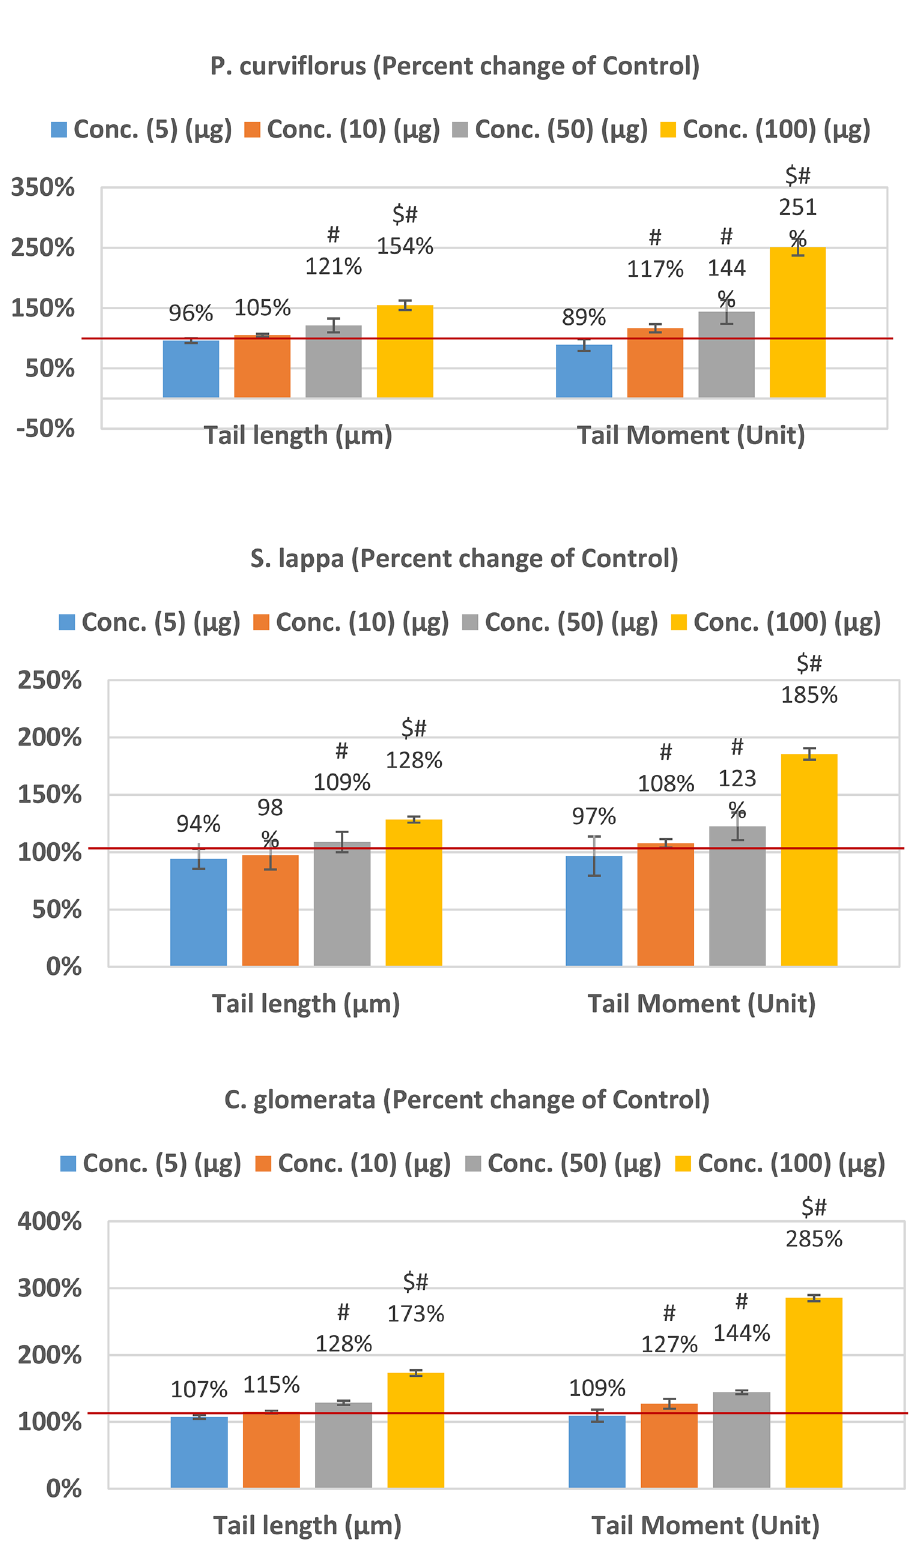
Figure 1. Percentage change of ( A ) P. curviflorus treated; ( B ) S. lappa treated; ( C ) C. glomerate tail length and tail moment compared to healthy untreated control